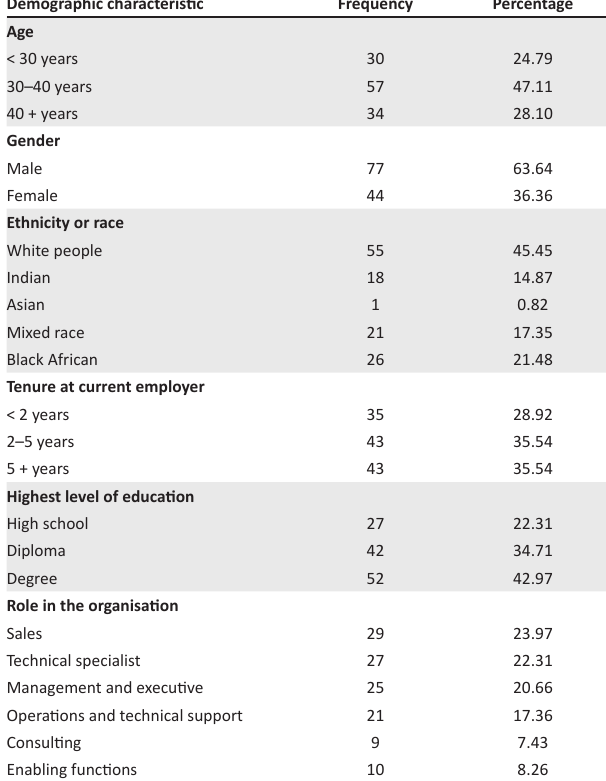
TABLE 2: Demographic characteristics of the sample ( N =